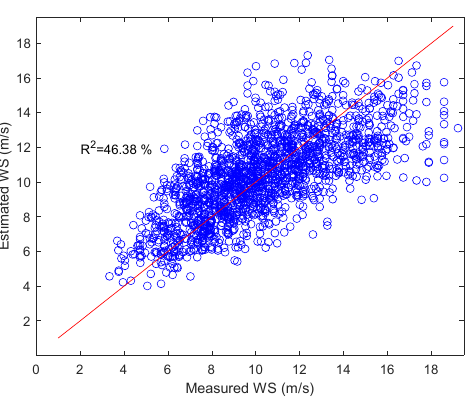
(c) RELM Scatter plot of estimated WS at180 m (d) RegTree Scatter plot of estimated WS at 180